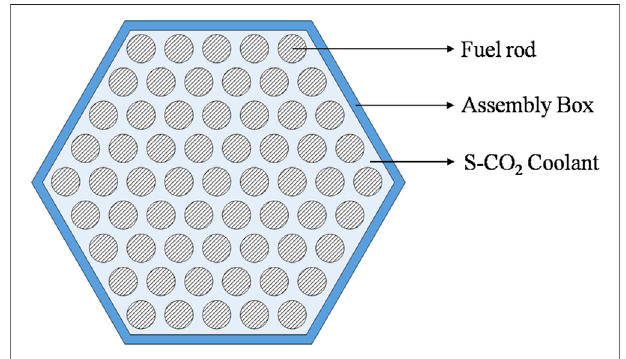
FIGURE 1 | The standard S-CO 2 fuel assembly.